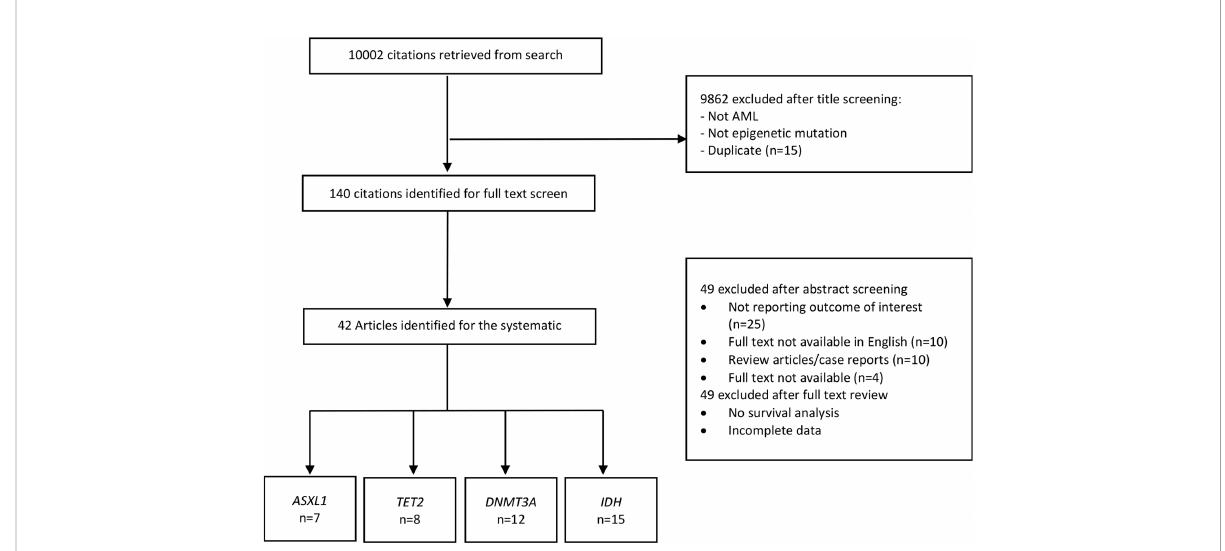
FIGURE 1 Study selection for the systematic review and meta-analysis. AML, Acute myeloid leukemia; ASXL1, Additional Sex Combs-Like 1; TET2, Ten-Eleven Translocation 2; DNMT3A, DNA Methyltransferase 3 Alpha; IDH, Isocitrate